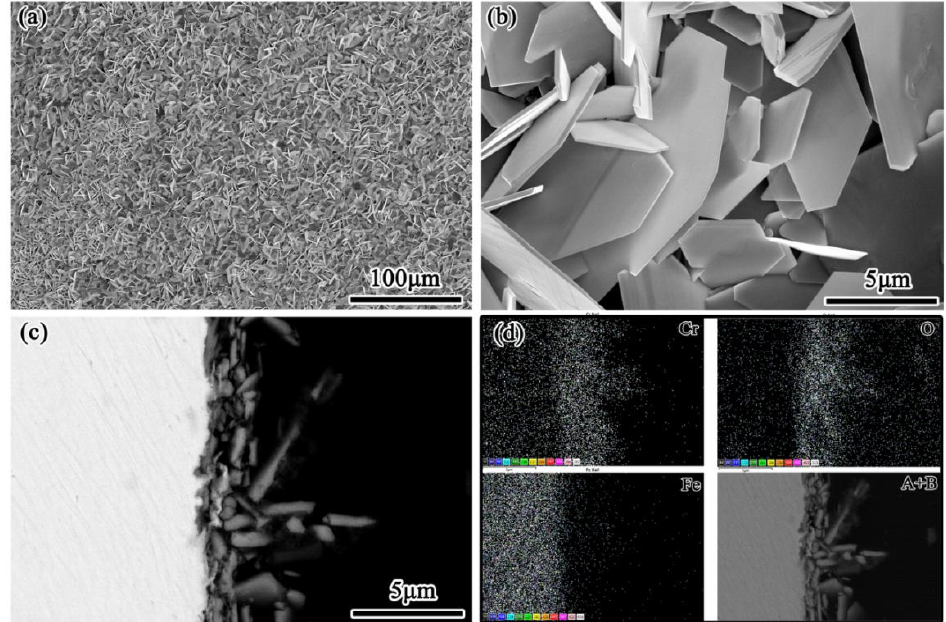
Figure 5. Low-magnification morphology ( a ), high-magnification surface image ( b ), cross-sectional image ( c ), and elemental map-scan profile (analyzed by EDS) ( d ) of the MSS after 100 h oxidation at 650 °C.